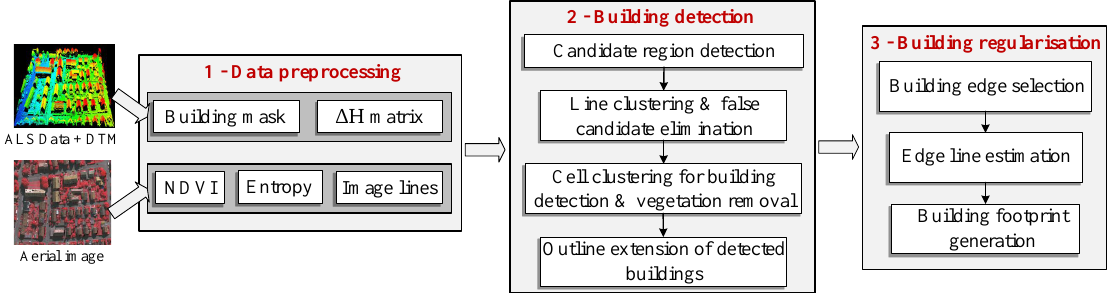
Figure 2. Workflow of the proposed building detection and regularisation